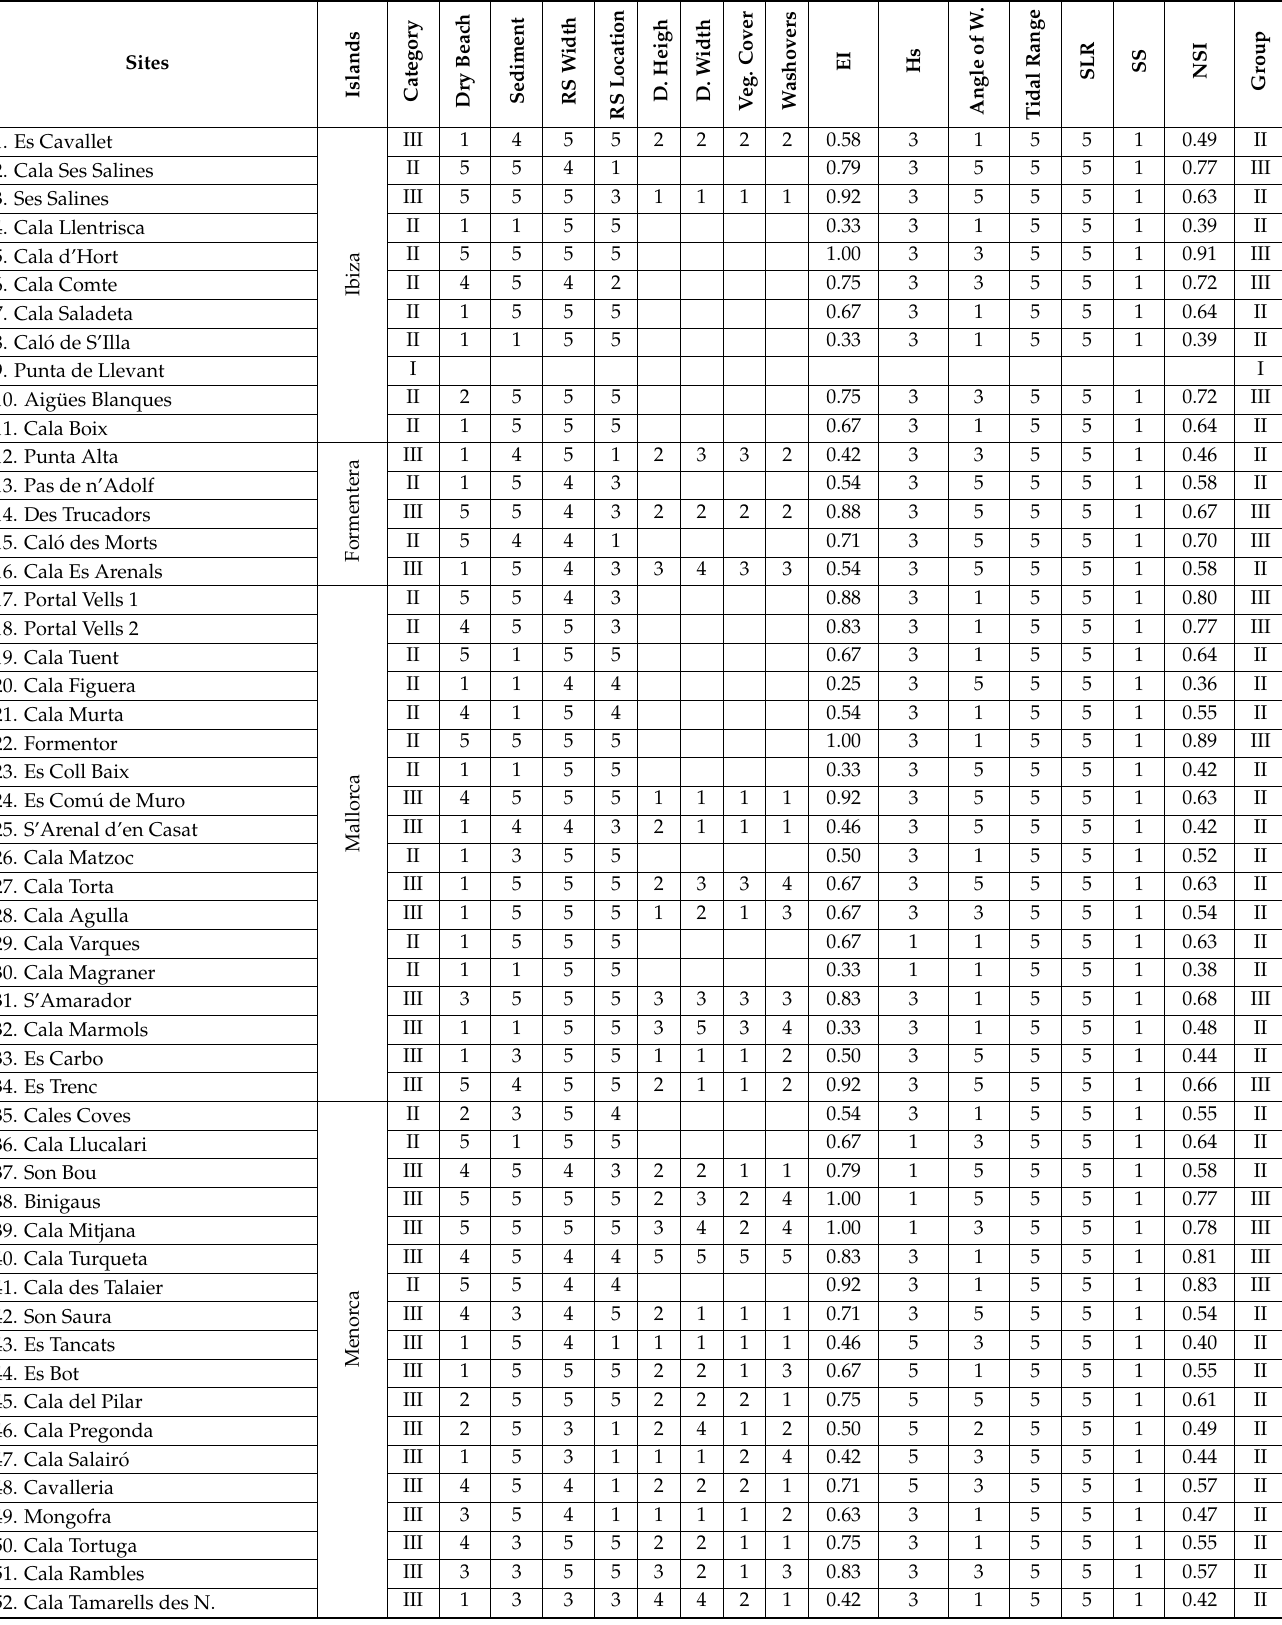
Table A3. Sites values at natural scenic sensitivity parameters (CSSI